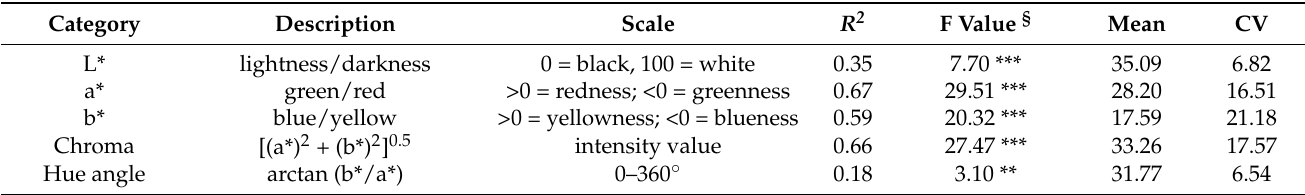
Table 5. Descriptive statistics for CIELab values scored on mature chilli